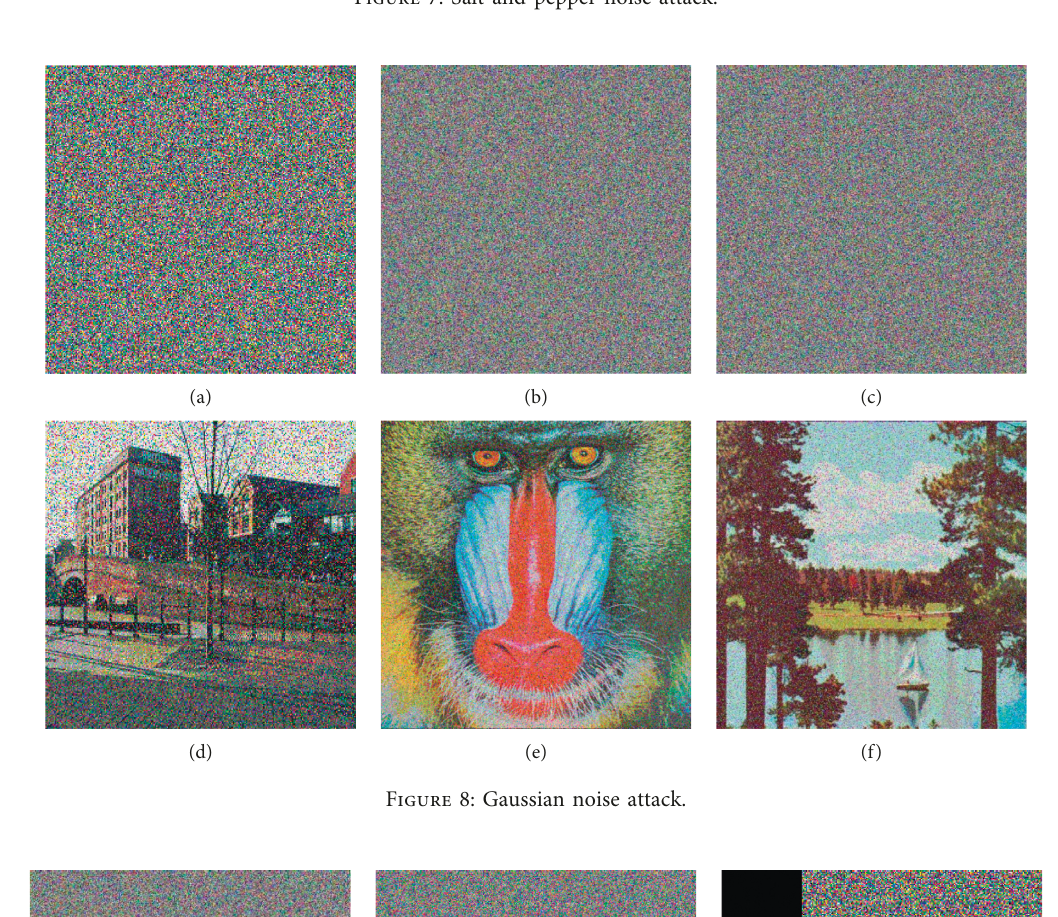
Figure 8: Gaussian noise attack.